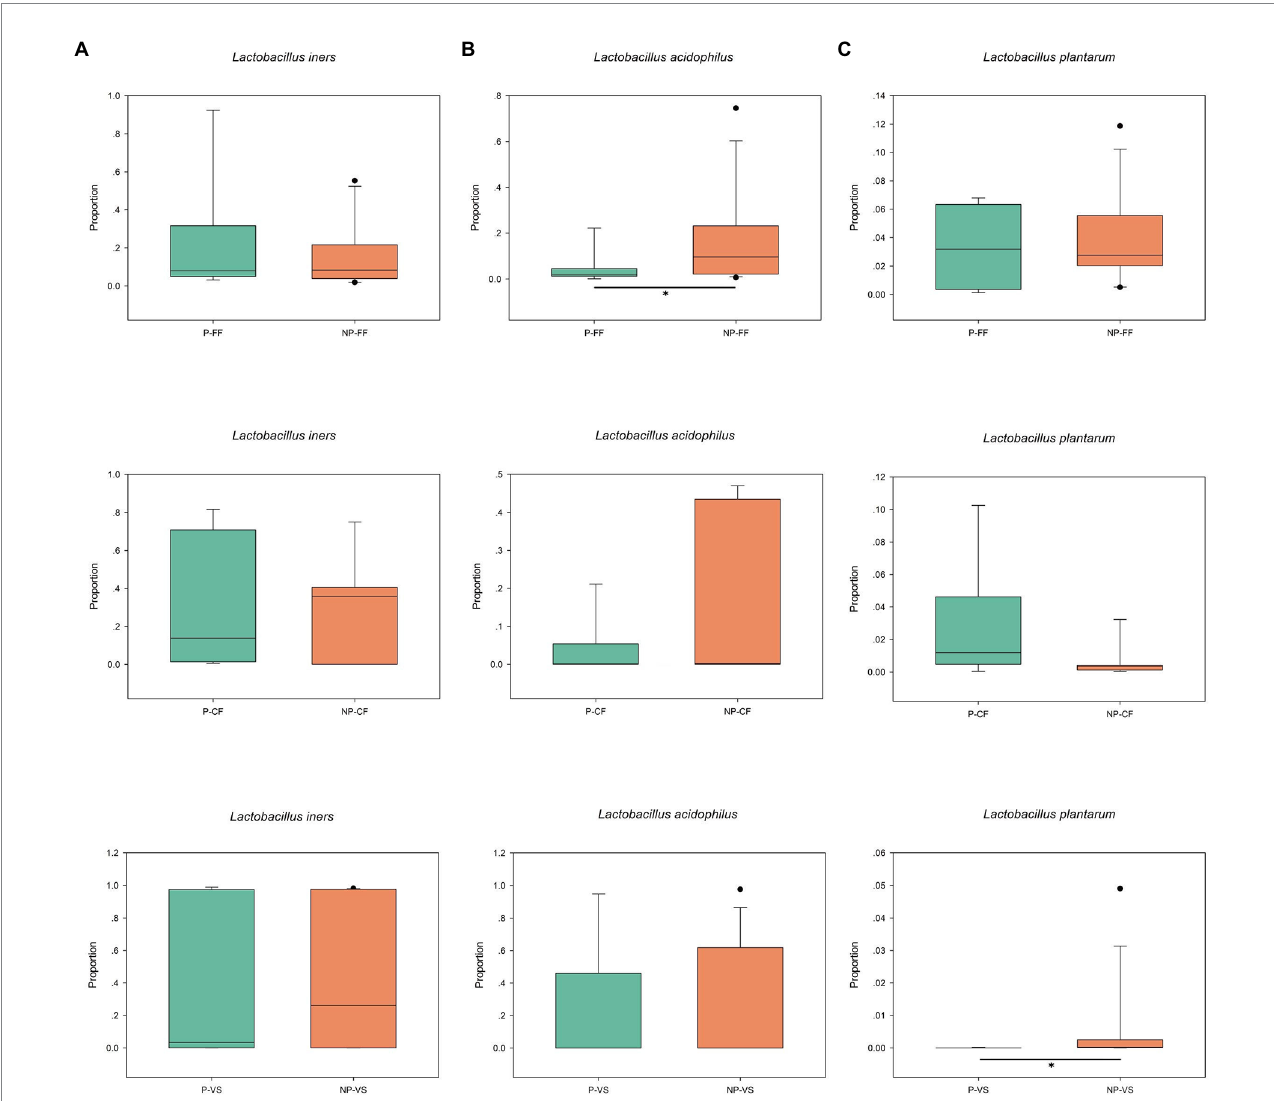
FIGURE 9 Relative abundance of different Lactobacillus species at three reproductive tract sites of different pregnancy outcomes. (A) Follicular fluid, (B) cervix, (C) vagina. The points on the top of the boxes are the outliers. Wilcoxon rank-sum test, p values represented as * p < 0.05, ** p <